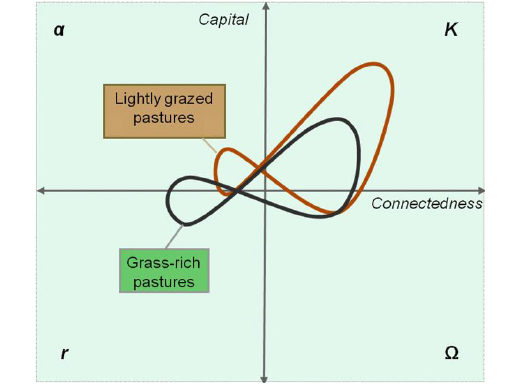
Fig. 4 . Two adaptive cycles for different grazing regimes and objectives (based on Gunderson and Holling